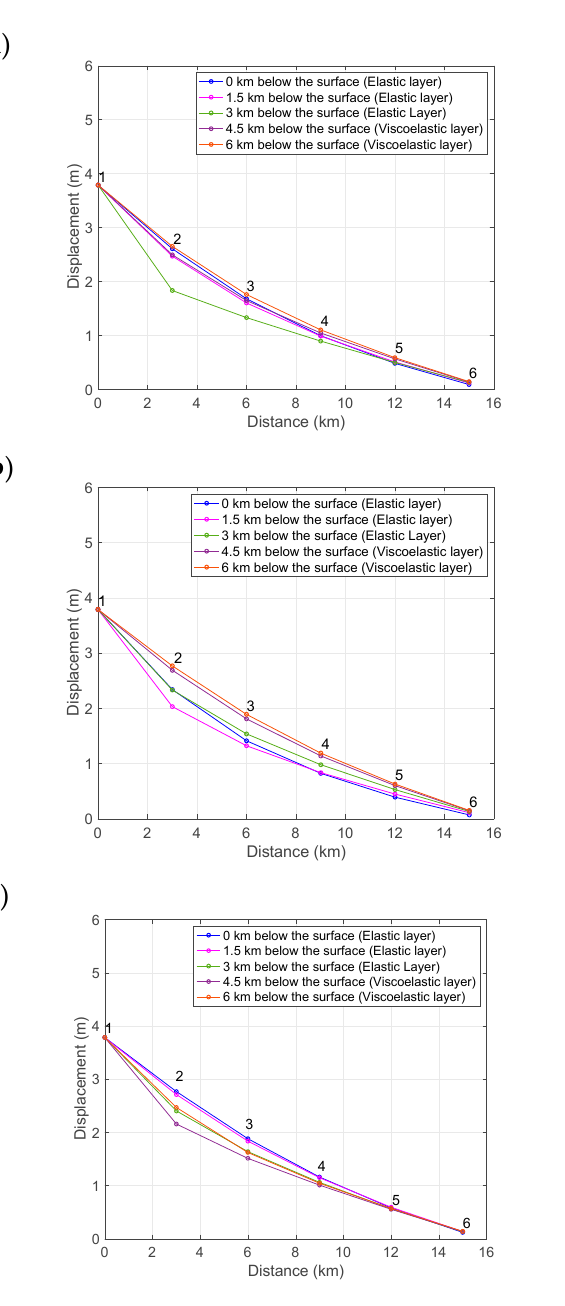
Figure 8. Displacement with the distance of strain release model with slip of 7.575 m in three scenarios ( left ) at 505 years and ( right ) at 750 years for ( a ) scenario one, ( b ) scenario two, and ( c ) scenario three. This increase is related to the coseismic phase, in which the energy or strain is released during an earthquake with significant slip. The viscoelastic material in the lower crust and upper mantle moves similar to a “viscous flow” that is capable of accumulating strain and transferring the stress to the layer above it (upper crust or elastic layer) so that the most significant differential stress is at the boundary of each layer, which is the area where the transfer occurs. Figure 9 also shows the interseismic phase marked by a gradual decrease in differential stress. The decrease occurs over 100 to 150 years from the earthquake